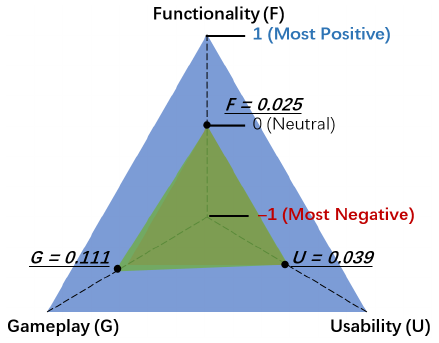
Figure 3. Overall playability score for